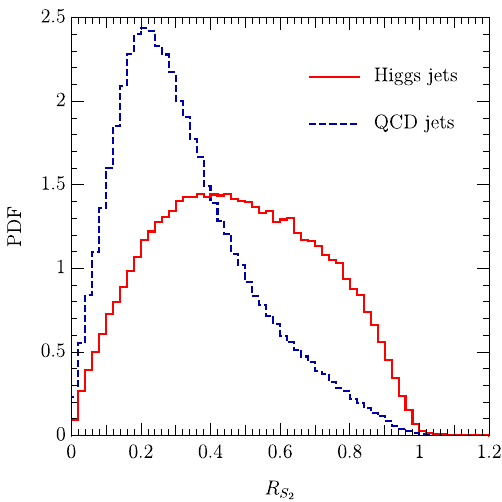
Figure 3 . Histogram of R S of the Higgs jets and the QCD jets in the training sample. The bin 2 height is the probability distribution function (PDF) of the given bin.